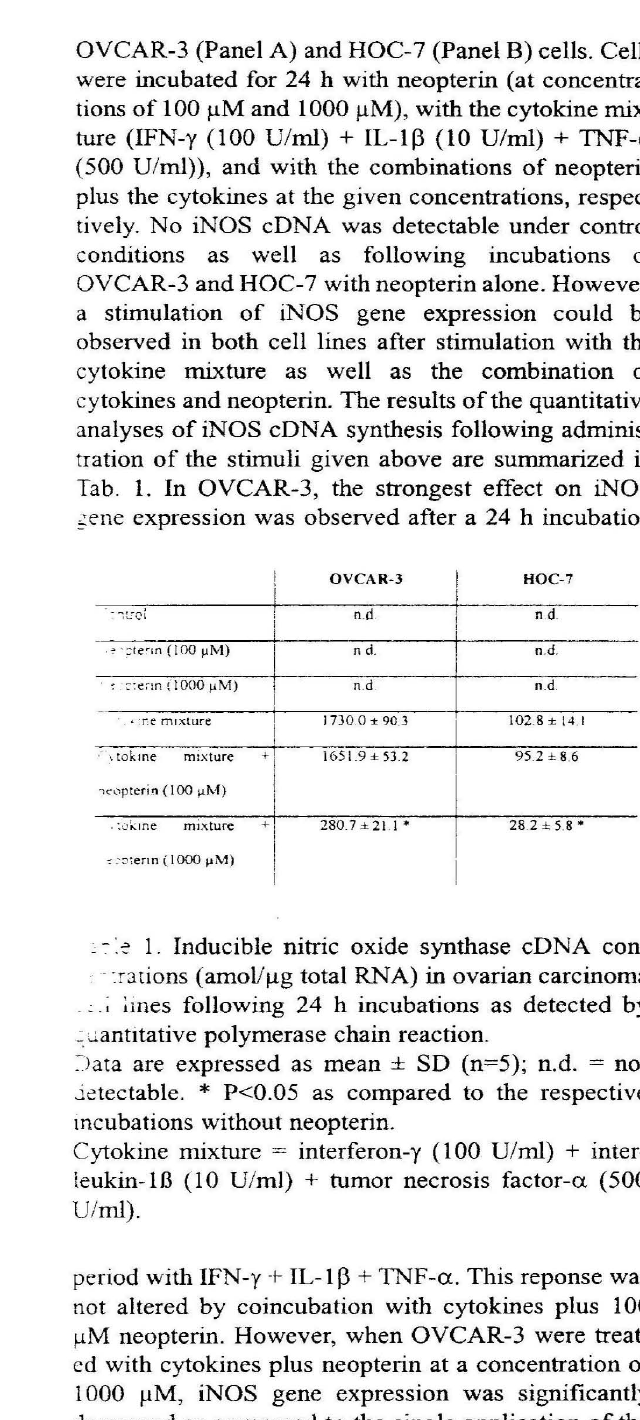
ments. Cytokine mixture = interferon-y (100 U/rnl) + interleukin-l B (10 U/ml) + tumor necrosis factor-a (500